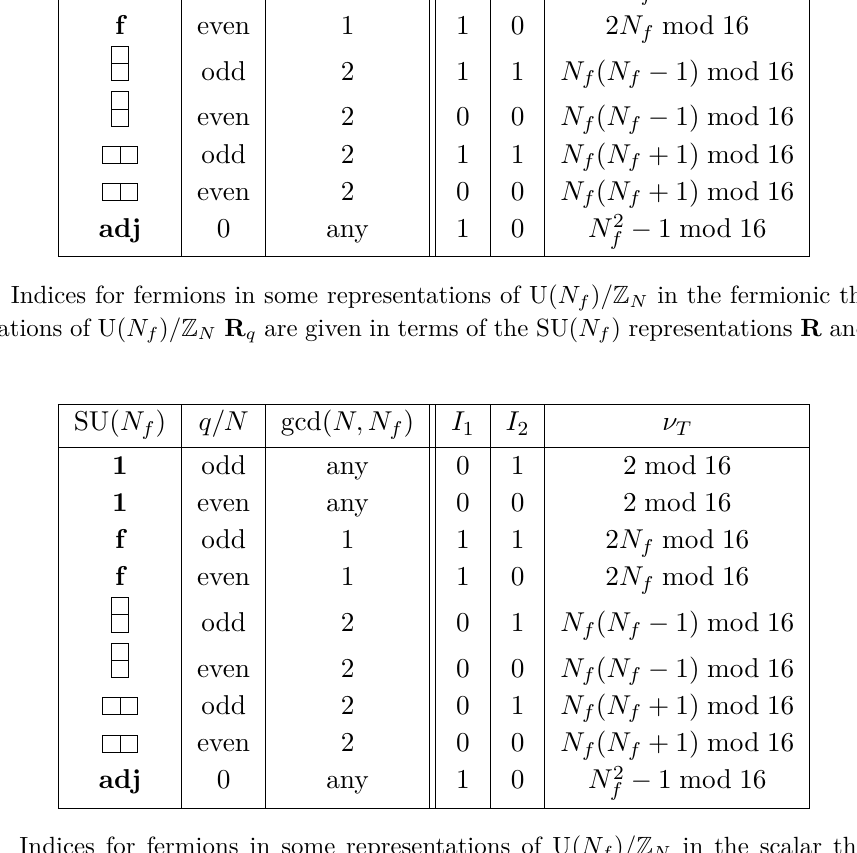
Table 2 . Indices for fermions in some representations of U ( N f ) / Z N in the scalar theory. The representations of U ( N f ) / Z N R q are given in terms of the SU( N f ) representations R and the U(1) charge q